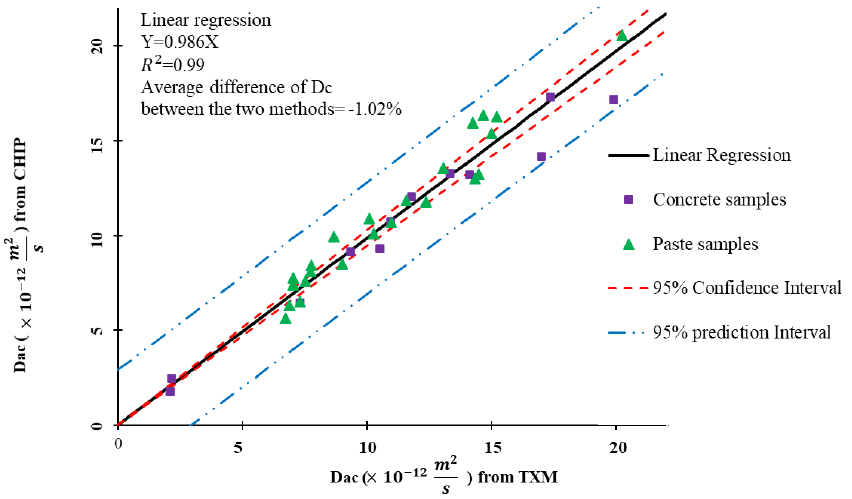
Figure 10. Comparison between TXM and CHIP diffusion coefficients for all tested samples.